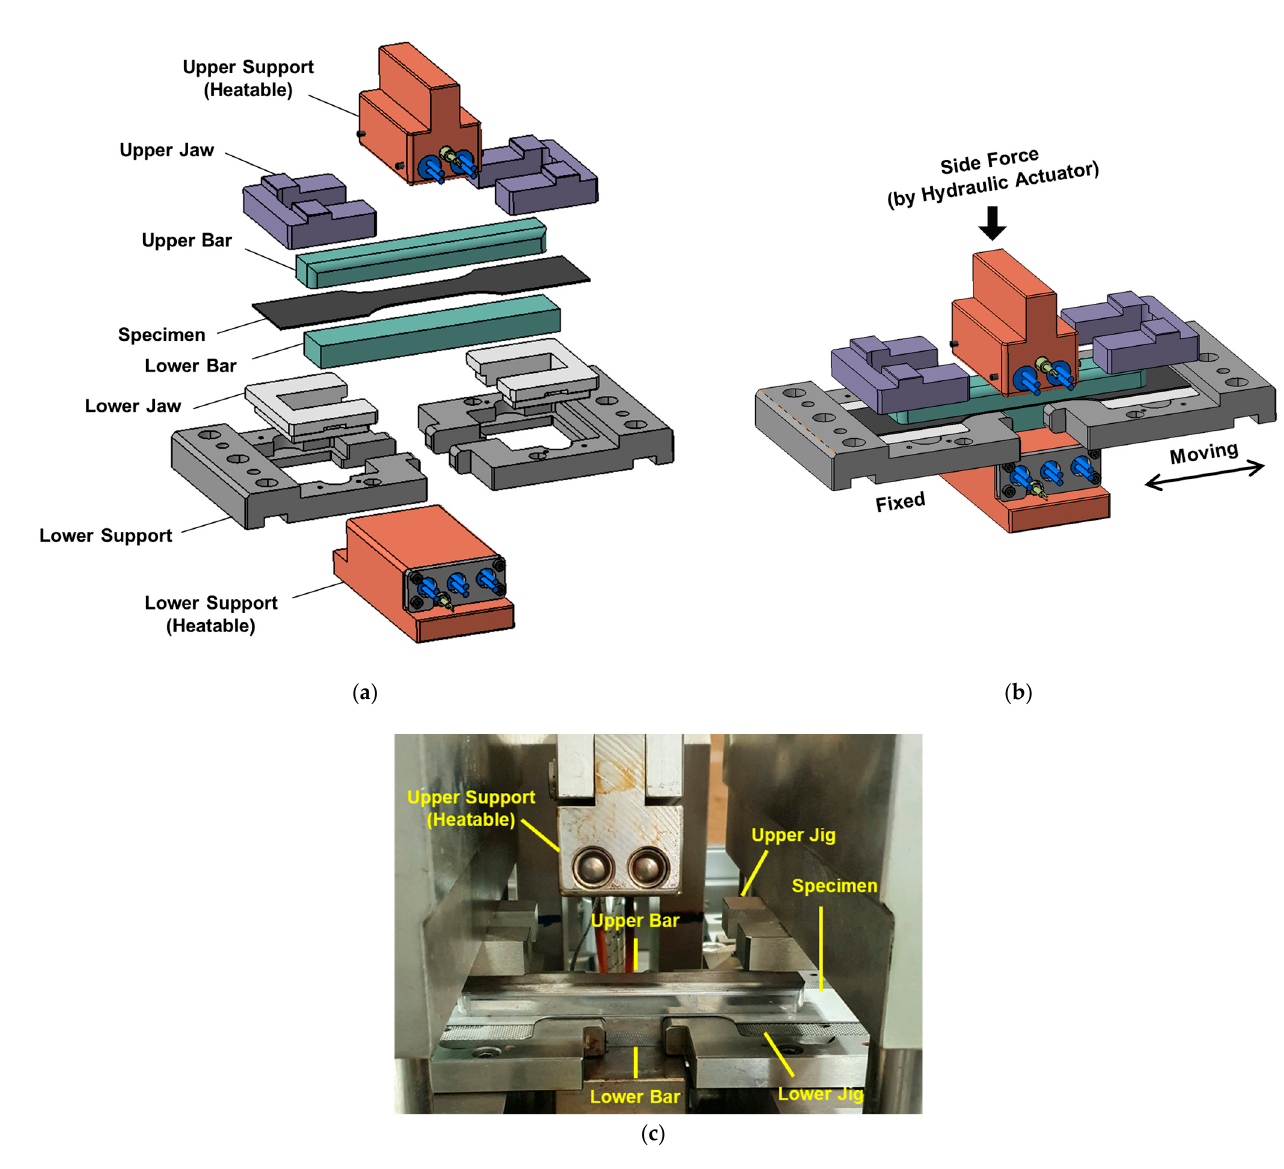
Figure 1. Tension–compression tester: ( a ) the exploded and ( b ) assembled views, and ( c ) the experimental setup.